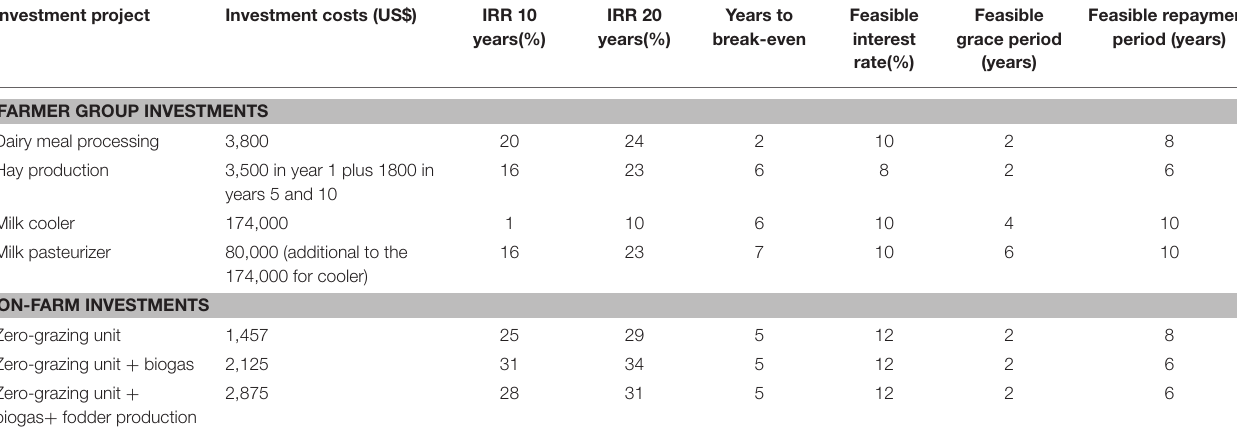
TABLE 1 | Analysis of feasible credit terms for selected group/cooperative and farmer investments. Investment